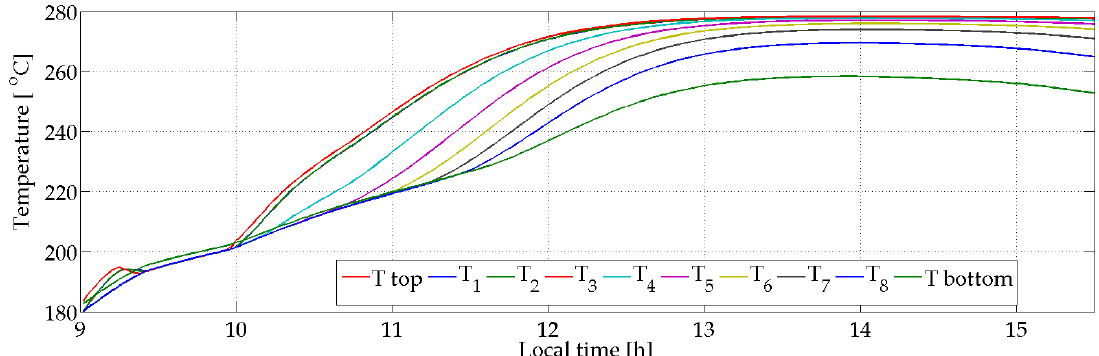
Figure 8. Evolution of the simulated oil temperatures during an experiment.